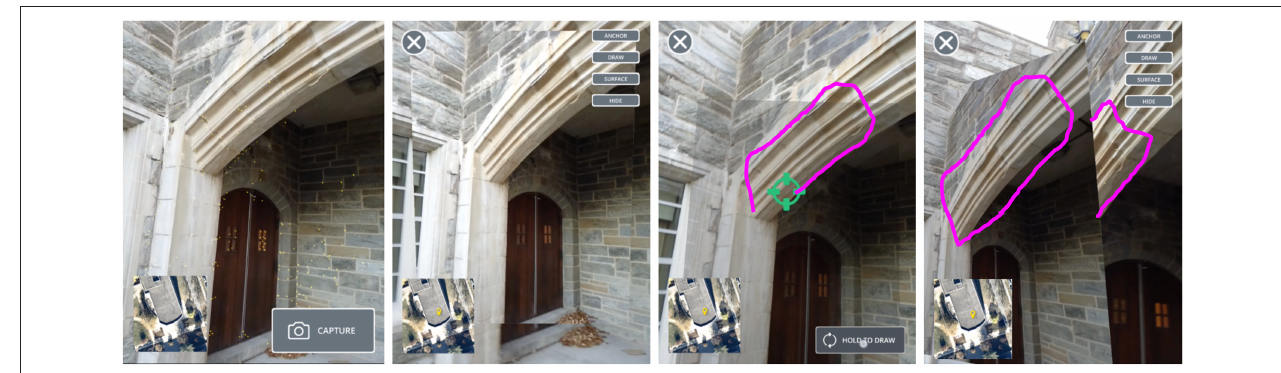
FIGURE 12 | Screen shots of the application utilized for building pathology. The first panel shows the initial capture scene, the second panel shows the annotation screen with the captured image, the third panel shows the annotation being taken on the point cloud, and fourth panel shows the annotation projected back onto the image for off site